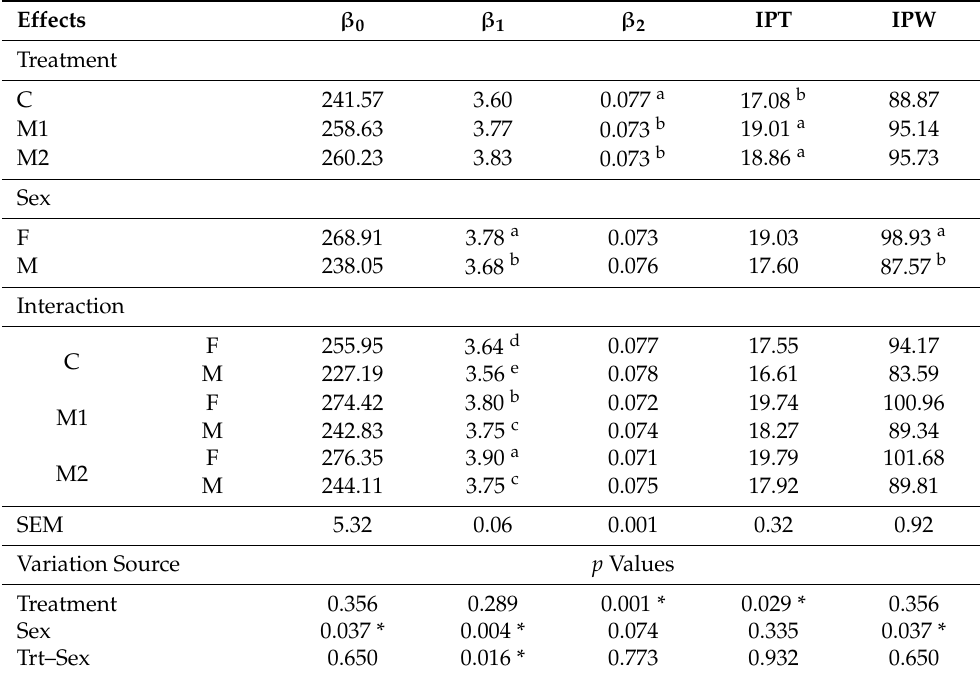
Table 4. The mean values of Gompertz growth curve parameters and results of variance